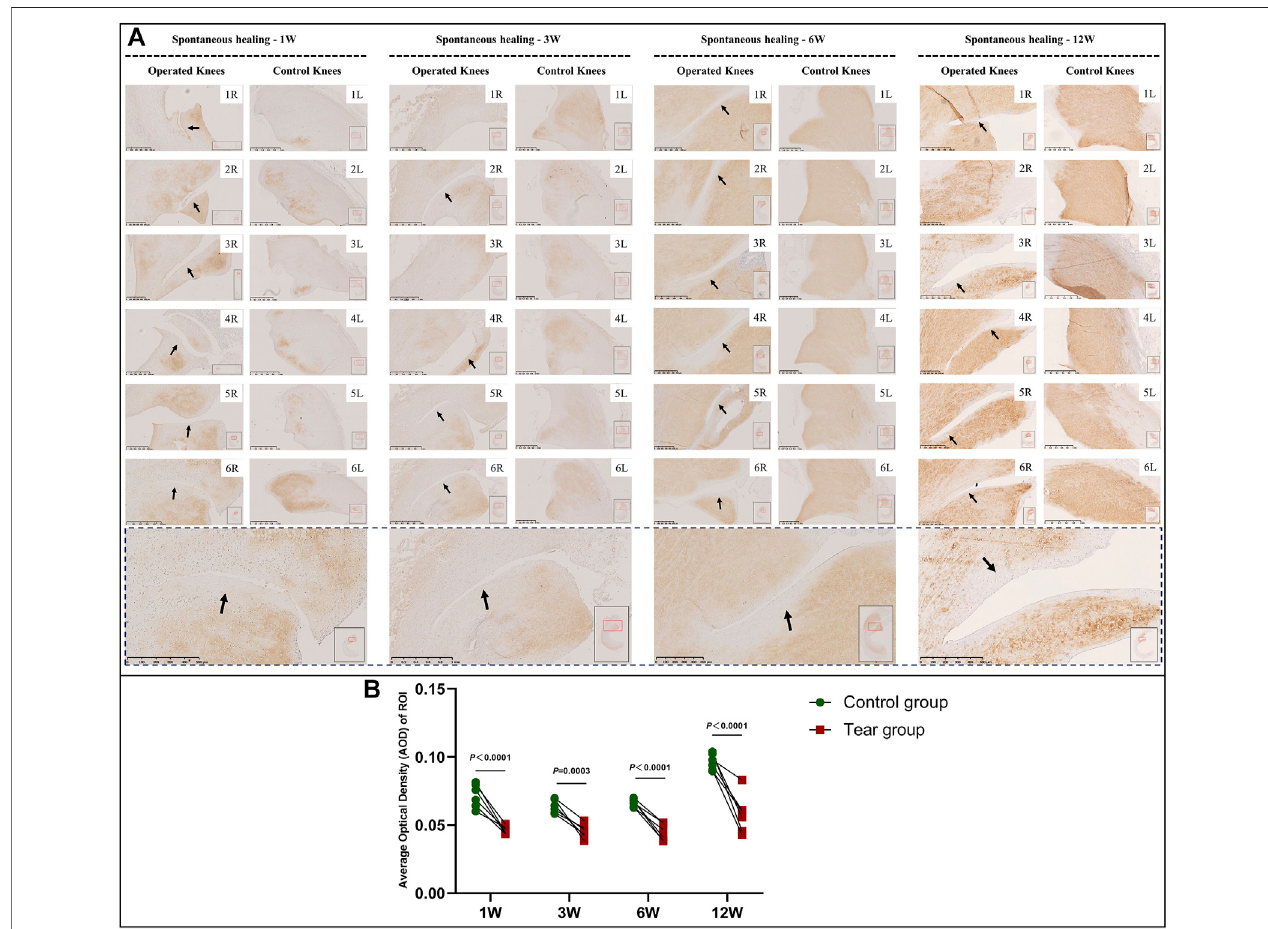
FIGURE 8 | Immunohistochemical and semiquantitative evaluation of type 2 collagen content in immature menisci. (A) Immunohistochemical staining of type 2 collagen. (B) Semiquantitativeevaluationoftype2collagencontent.Theblackarrowsindicatefadingofdiaminobenzidine(DAB)stainusedfortype2collagen.Thelower panelofimageswithablackdotted-lineborderindicaterepresentativespecimensinthecorrespondingobservationperiod.AODvaluesareexpressedasmedianvalues with 95% CIs. n (cid:1) 6.